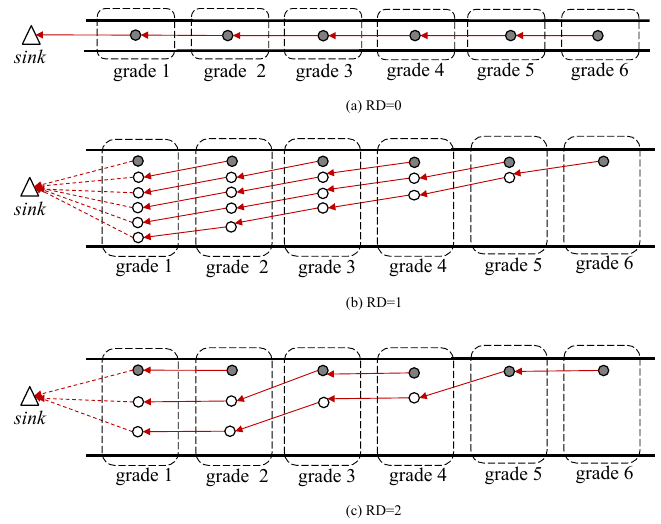
Figure 5. Topologies corresponding to different RD values, where total number of grades N is 6. Note that each red arrow indicates the packet transmitting route of a node recorded in its routing